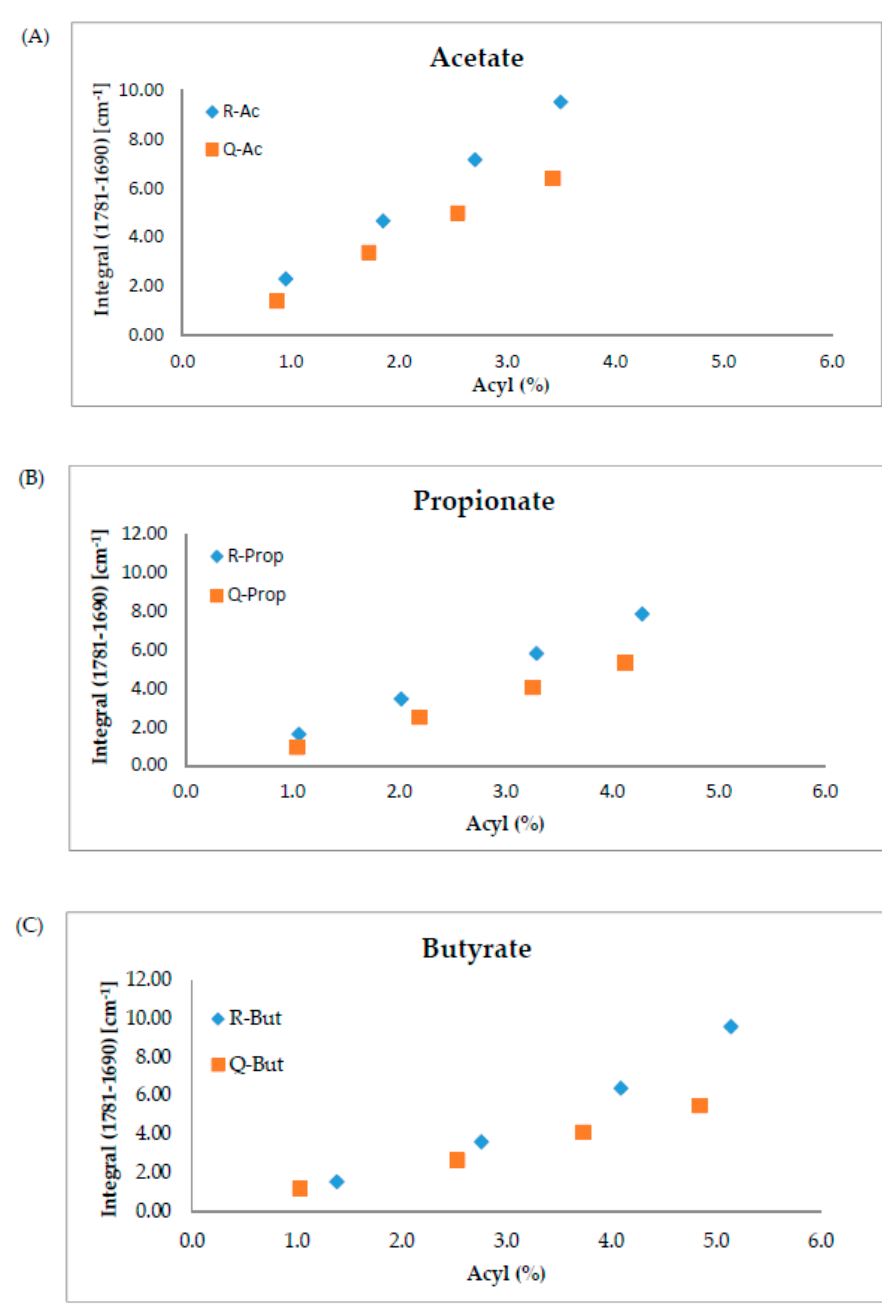
Figure 4. Correlation between acyl content obtained from stoichiometric equation and integral values of the carbonyl stretching vibration (C = O) band from FTIR of esterified starches; ( A ) acetylated rice and quinoa starches, ( B ) propionylated rice and quinoa starches, and ( C ) butyrylated rice and quinoa starches.